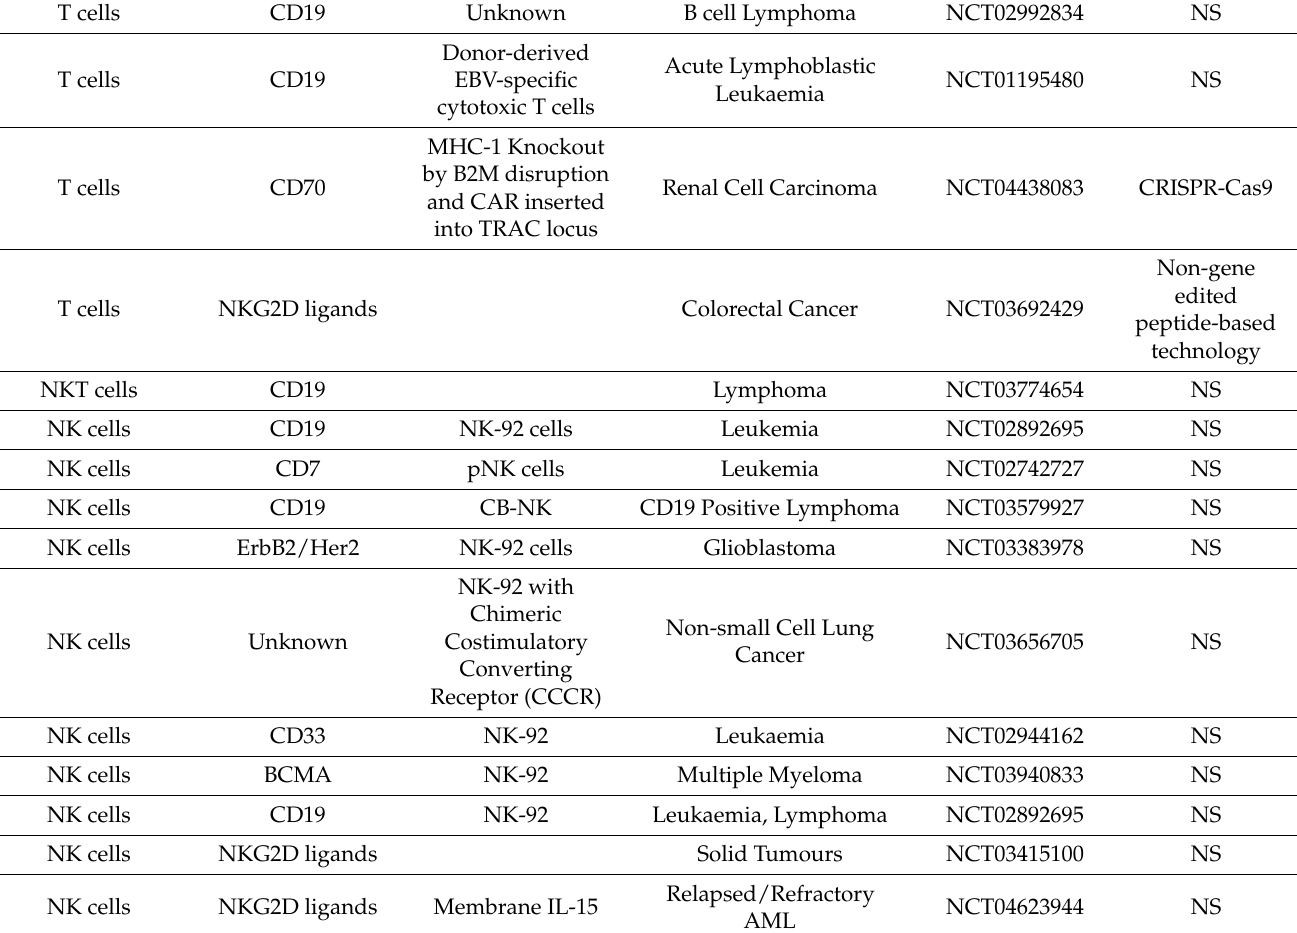
Abbreviations: TRAC, T cell receptor alpha locus. NS, Not